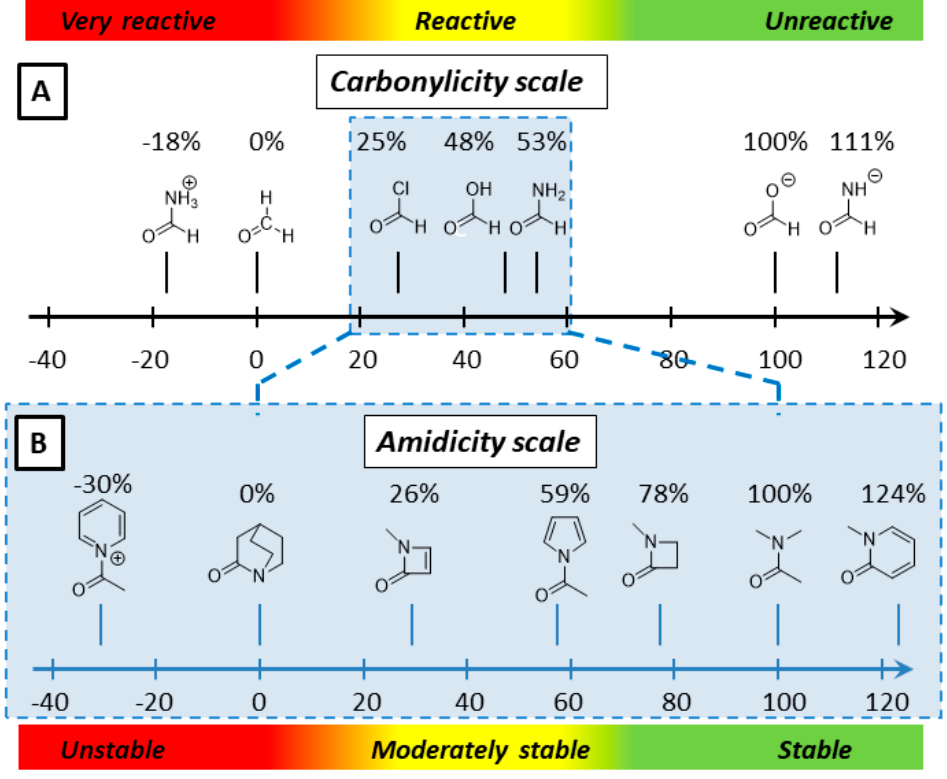
Figure 2. Typical carbonyl and amide compounds represented on the carbonylicity ( A ) and amidicity ( B ) scales. The direction of reactivity and stability increase are shown by red and green strips, respectively.